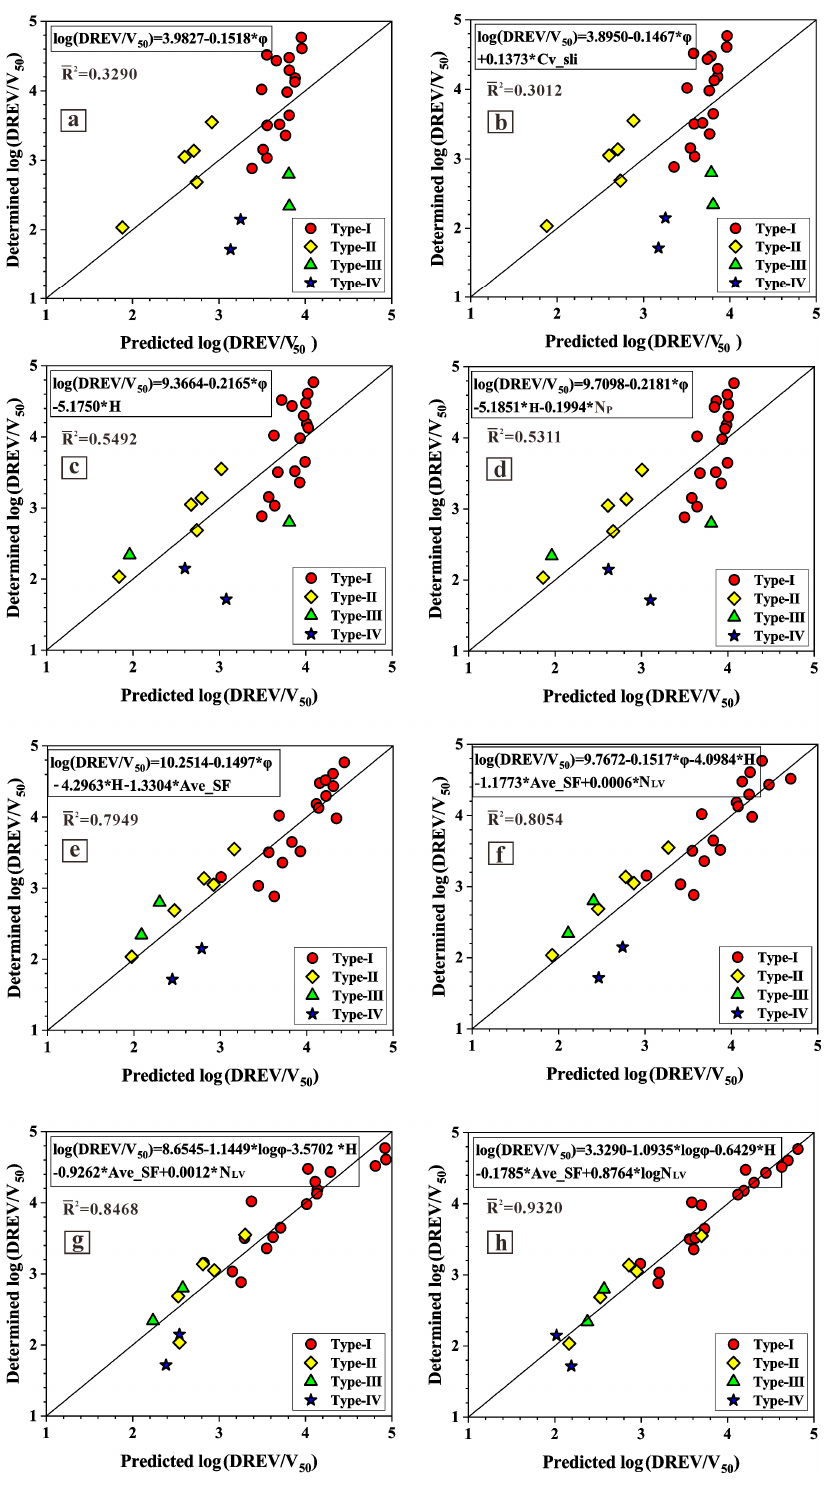
Figure 17. The fitting prediction model of DREV. ( a ) Fitting model established for ϕ . ( b ) Fitting model established for ϕ and Cv_sli. ( c ) Fitting model established for ϕ and H. ( d ) Fitting model established for ϕ , H and N P . ( e ) Fitting model established for ϕ , H and Ave_SF. ( f ) Fitting model established for ϕ , H, Ave_SF and N LV . ( g ) Fitting model established for log ϕ , H, Ave_SF and N LV ( h ) Fitting model established for log ϕ , H, Ave_SF and logN LV